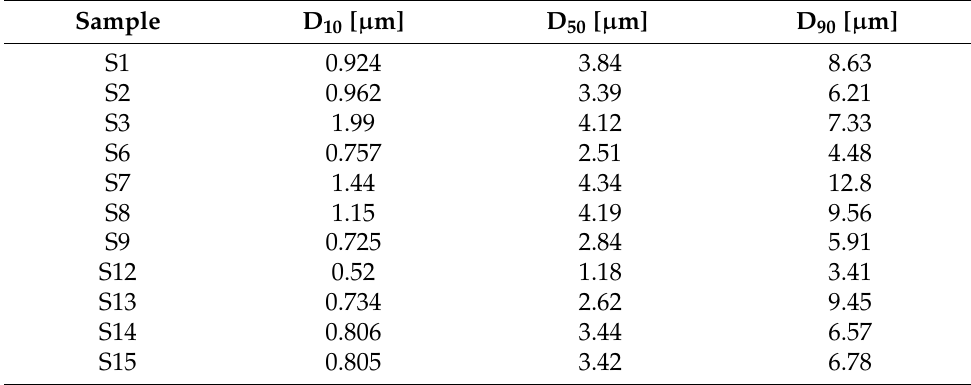
Table 3. Particle size analysis for a change in milling and synthesis